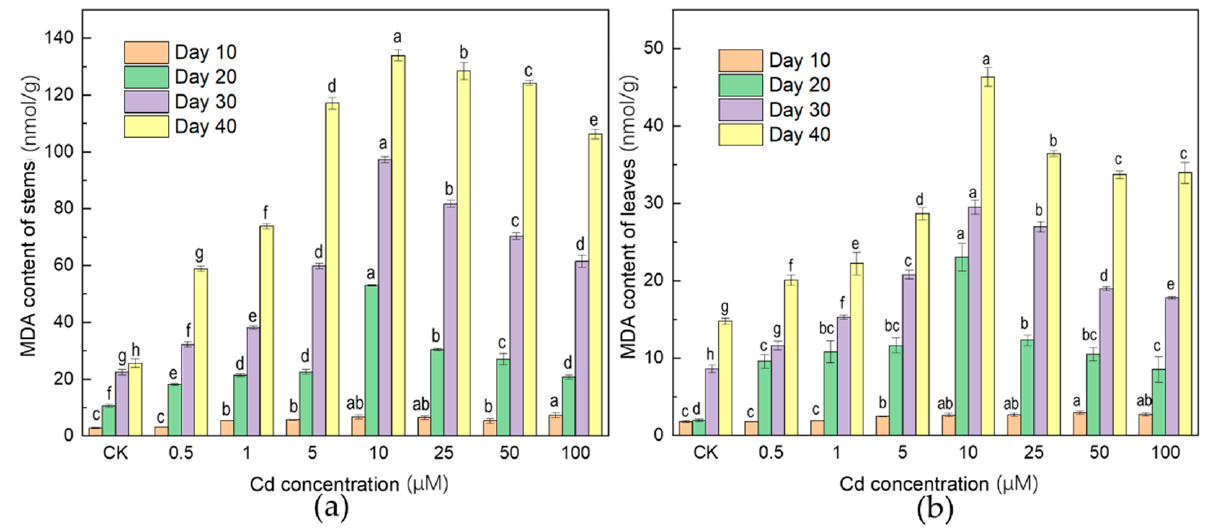
Figure 2. Changes of MDA content of A. selengensis after treatment with different concentrations of Cd, ( a ) stem, ( b ) leaf. The results are means ± SD ( n = 3), lower letters mean significant differences ( p < 0.05) between different Cd concentrations at the same treatment time.